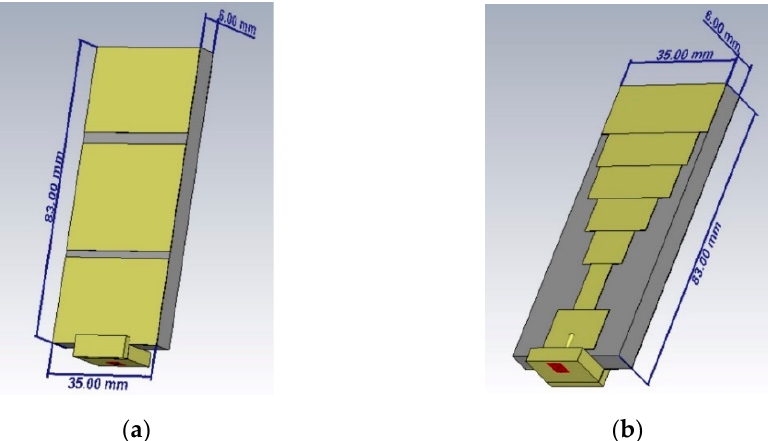
Figure 4. Stepped monopole antenna used as unobtrusive sensor ( a ) radiating front face ( b ) ground back face.